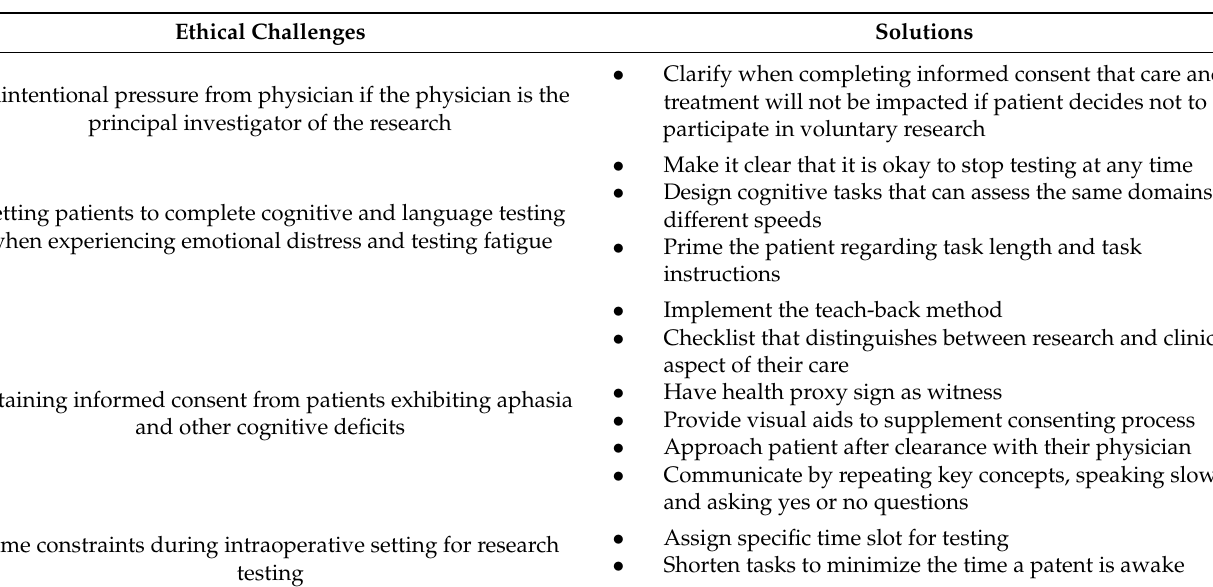
Table 2. Summary of ethical challenges and solutions for neuro-oncology